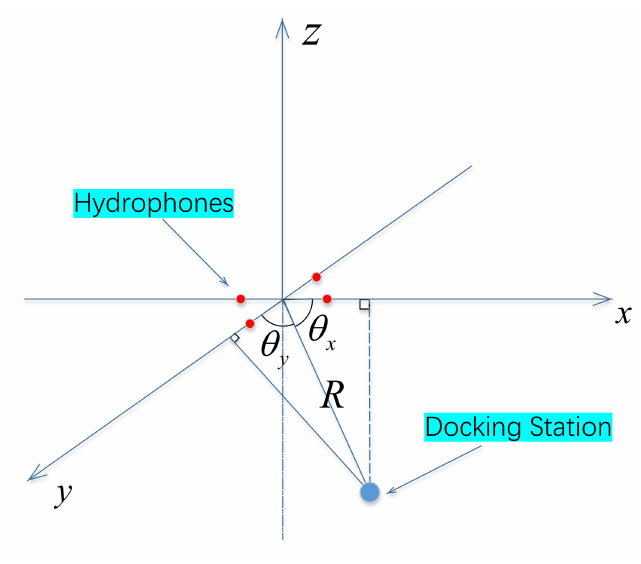
Figure 2. Positioning of AUV using